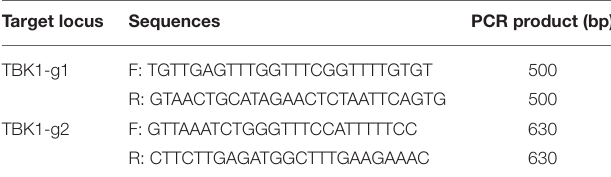
TABLE 1 | Primers used in sequence analysis for detection of